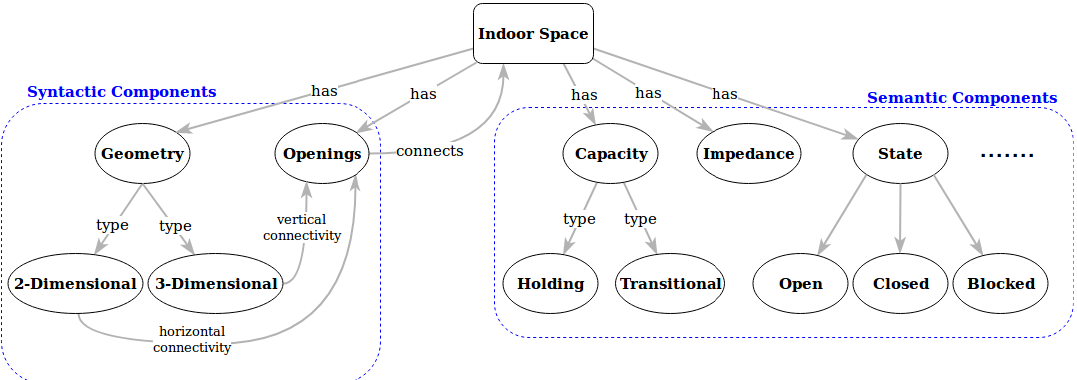
Figure 3. Properties associated with indoor space as defined in the ontological